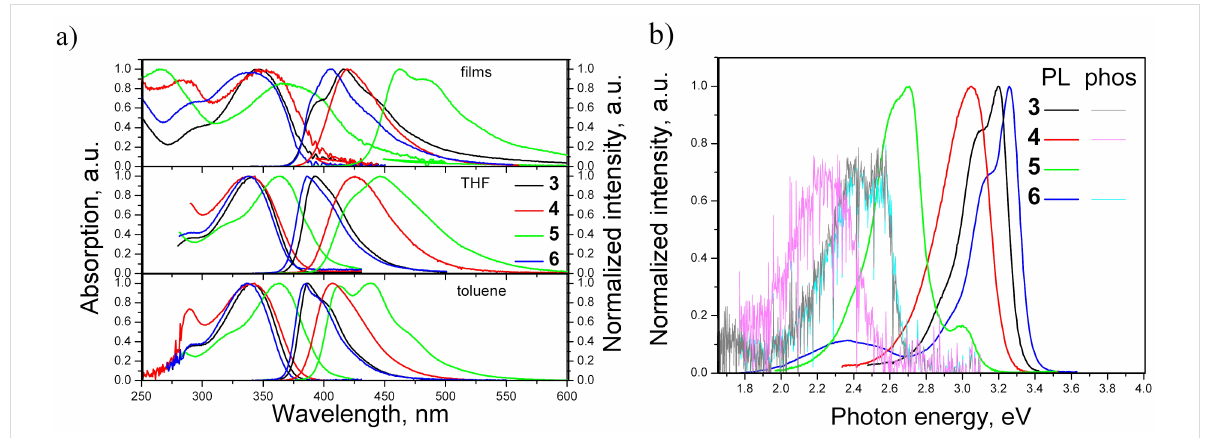
Figure 2: DSC curves of compounds 4 and 5 .